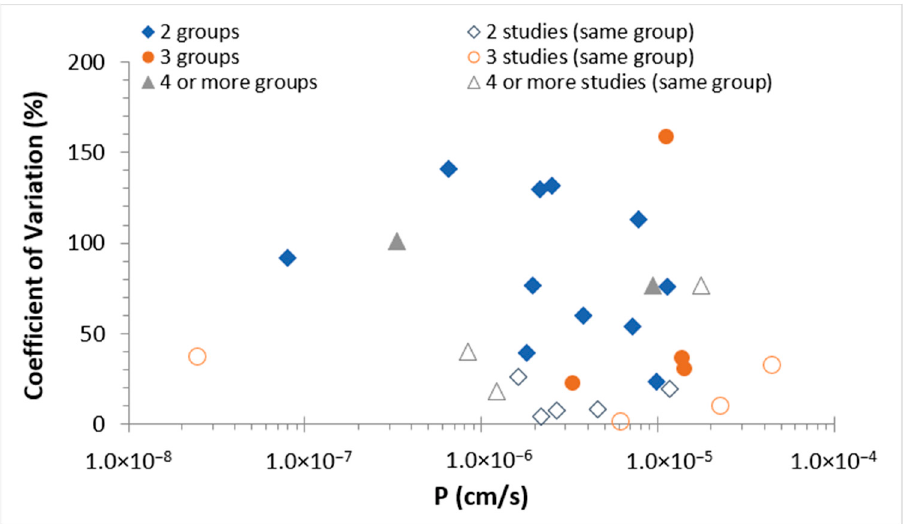
Figure 1. Assessment of permeation data variability. CV of the permeability data among different research groups were plotted against the average of the permeability data. In this case, CV was calculated using the reported mean values of the same permeant from different studies conducted by different research groups and plotted as a data point using the average of these values. CV of the data among different studies from the same research groups were also determined for comparison. In this case, CV was calculated using the reported mean values of the same permeant from different studies conducted by the same research group. Permeants in studies from different research groups are: antipyrine, atenolol, bupivacaine, buspirone, caffeine, didanosine, dideoxycytidine, estradiol, mannitol, metoprolol (2 data sets of different conditions), naltrexone, ondansetron, oxprenolol, propranolol (2 data sets of different conditions), and triamcinolone acetonide. Symbols: permeant data from two (closed diamonds), three (closed circles), and four or more (closed triangles) research groups. Permeants in studies from the same research groups are: acyclovir, antipyrine, caffeine, decitabine, diazepam, didanosine, estradiol, mannitol, morphine, nicotine (2 data sets of different conditions), triamcinolone acetonide. Symbols: permeant data from two (open diamonds), three (open circles), and four or more (open triangles) studies from the same research